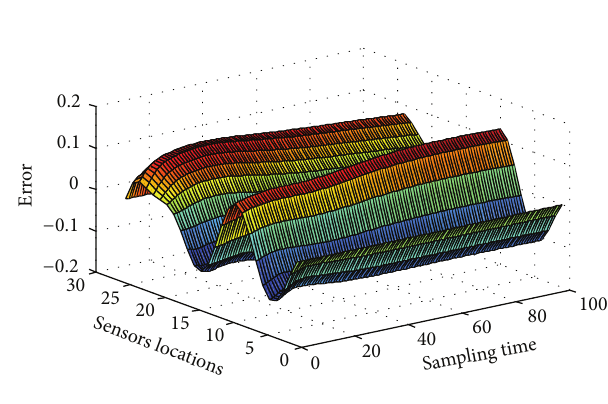
Figure 3: Predicted error based on 3 initial EEFs.